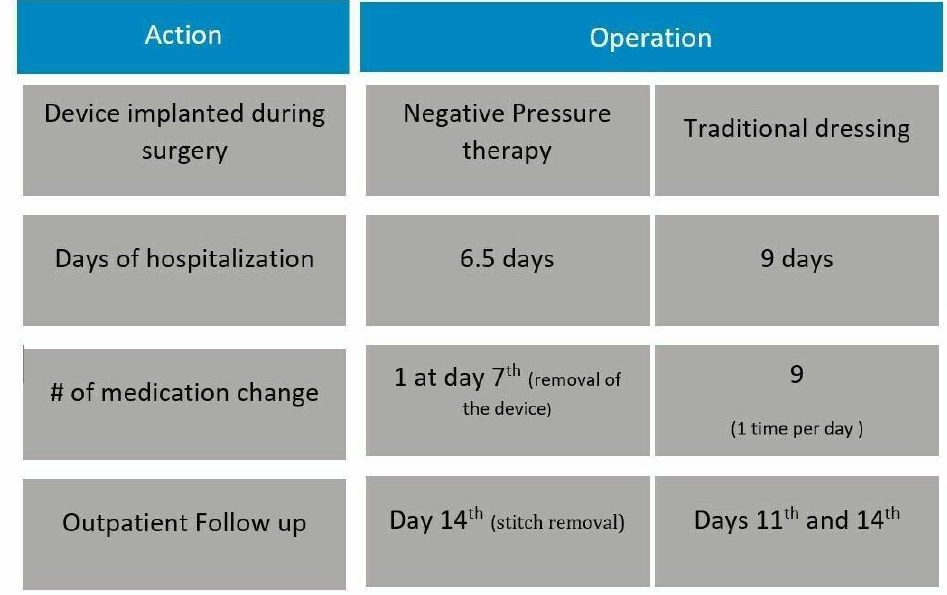
Figure 1. Patient pathways considering the innovative or traditional technology.